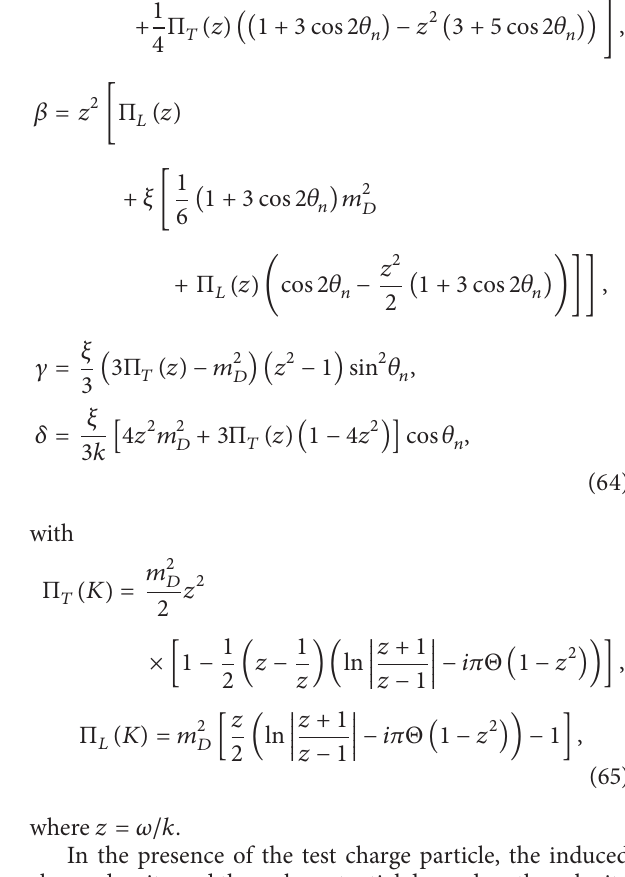
needed as compared to the case of higher initial